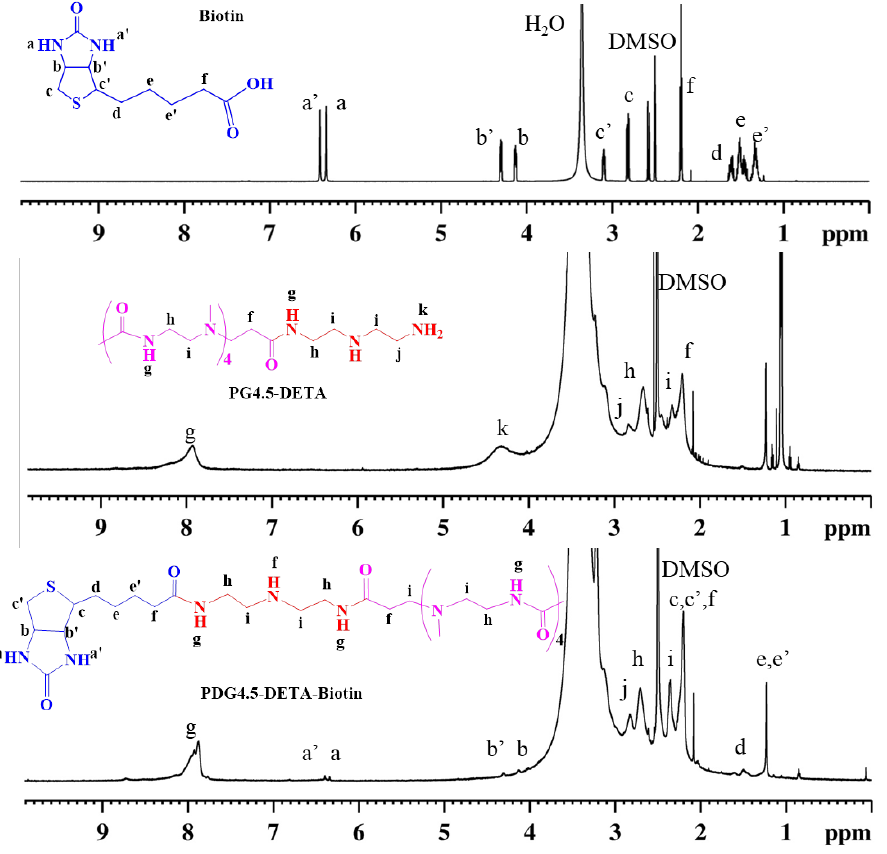
1 H NMR spectra of biotin, PG4.5-DETA, and PG4.5-DETA-biotin in DMSO-d6.